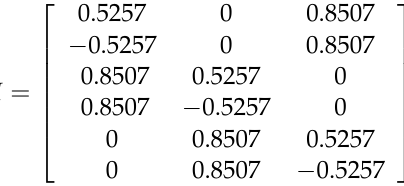
10  fault amplitude.